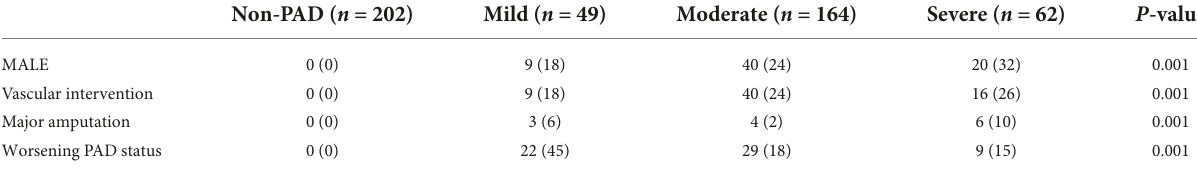
TABLE 3 Adverse events.